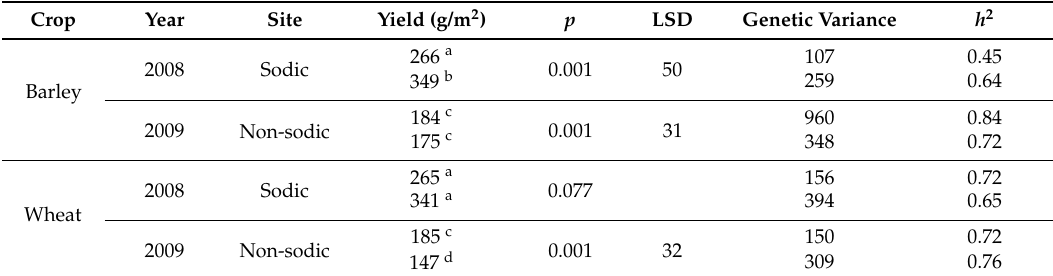
Table 2. Site mean grain yield, probability that genotypes differed within the experimental site ( p ), least significance difference between genotypes (LSD), genetic variance, and heritability ( h 2 ) for wheat and barley grown at a sodic and a non-sodic site near Goondiwindi in southern Queensland in 2008 and